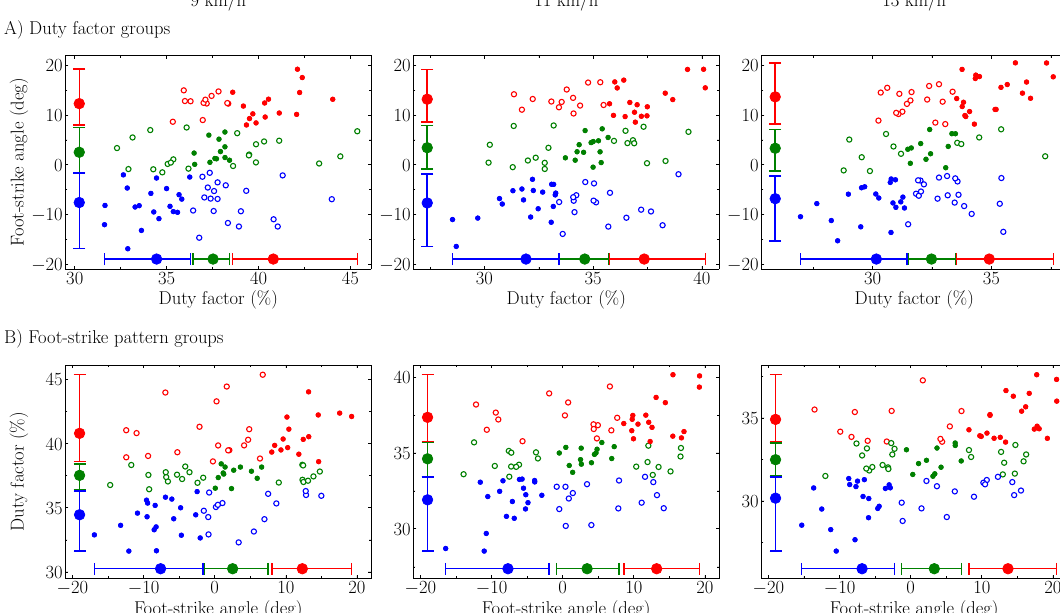
Figure 2. Duty factor (DF) and foot-strike angle (FSA) values of runners attributed to ( A ) a DF group but not being classified in the supposedly corresponding foot-strike pattern (FSP) group and ( B ) a FSP group but not being classified in the supposedly corresponding DF group at each tested running speed. Mean DF and FSA value (filled circle) and range of values (whiskers) for each DF and FSP group, i.e., high DF runners and rearfoot strikers (RFS; red), mid DF runners and midfoot strikers (MFS; green), and low DF runners and forefoot strikers (FFS; blue). The upper whisker extends to the maximum while the lower whisker extends to the minimum value. Empty circles denote the runners attributed to a DF or FSP group but not being classified in the supposedly corresponding FSP or DF group, respectively, e.g., high DF runners but classified as MFS or FFS (green and blue empty circles within the red whiskers of the high DF runners) in ( A ) and RFS but classified as mid or low DF runners (green and blue empty circles within the red whiskers of RFS) in ( B